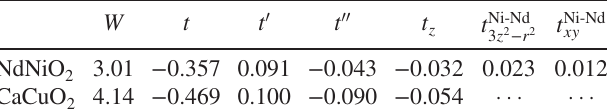
TABLE II. Bandwidth W and near-neighbor hopping param- eters (in eV) for the NdNiO 2 and CaCuO 2 narrow energy window Wannier Hamiltonians. Here, t , t 0 , and t 00 are the first-, second-, and third-neighbor in-plane hopping parameters (further neighbor hoppings are smaller, thus not shown), t is the nearest-neighbor z interplane hopping parameter, and t Ni − Nd is the largest hybridi- zation found between the Ni d and the two Nd- 5 d orbitals. x 2 − y 2